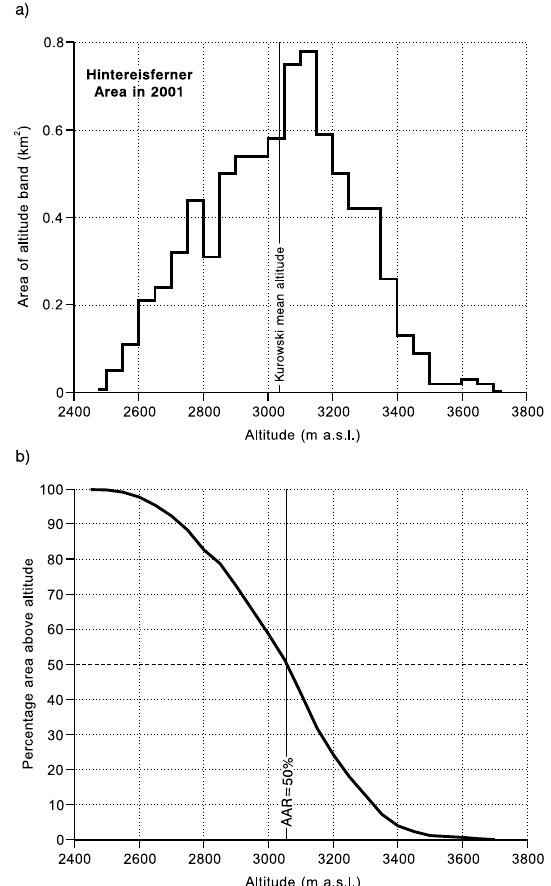
Figure 1. Area–altitude distribution for Hintereisferner, Austrian Alps, for the year 2001: (a) shows areas of altitude bands vs. their mean altitudes; (b) shows percentage of glacier area above any par- ticular